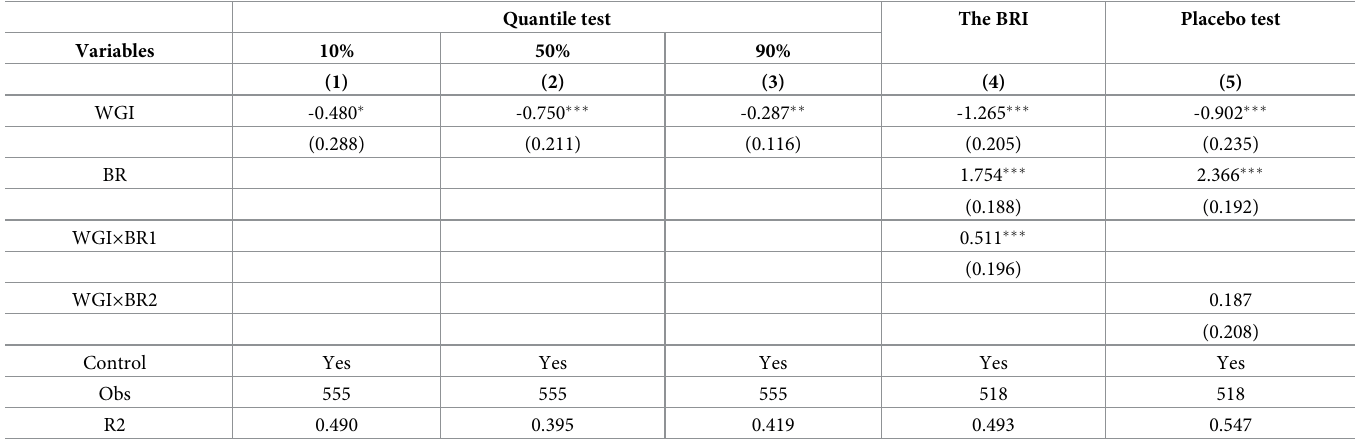
Table 6. Estimated results for further